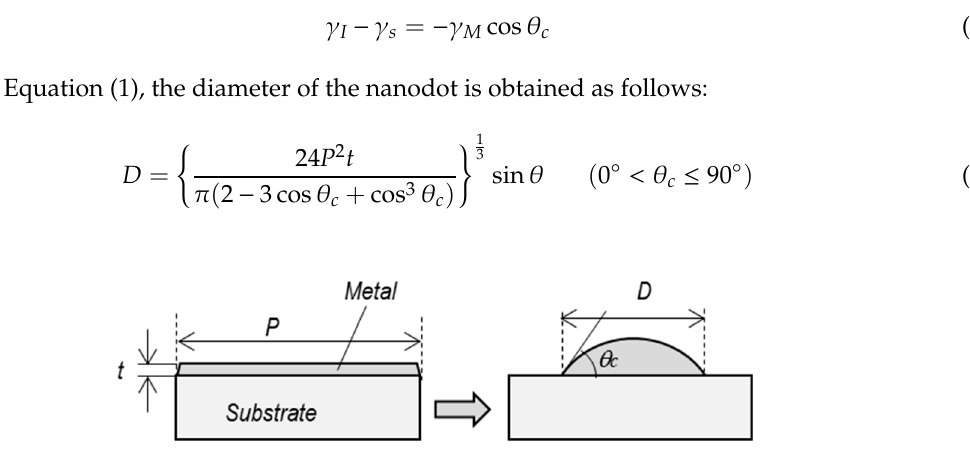
Figure 4. Variation of average nanodot size and its standard deviation against grid size.